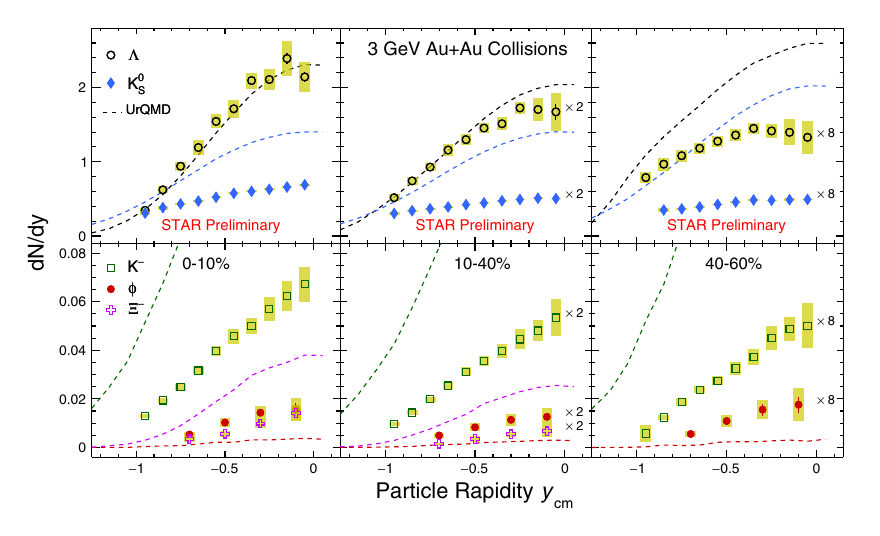
, K − ,ϕ and Ξ − in Au + Au collisions at √ s = NN S